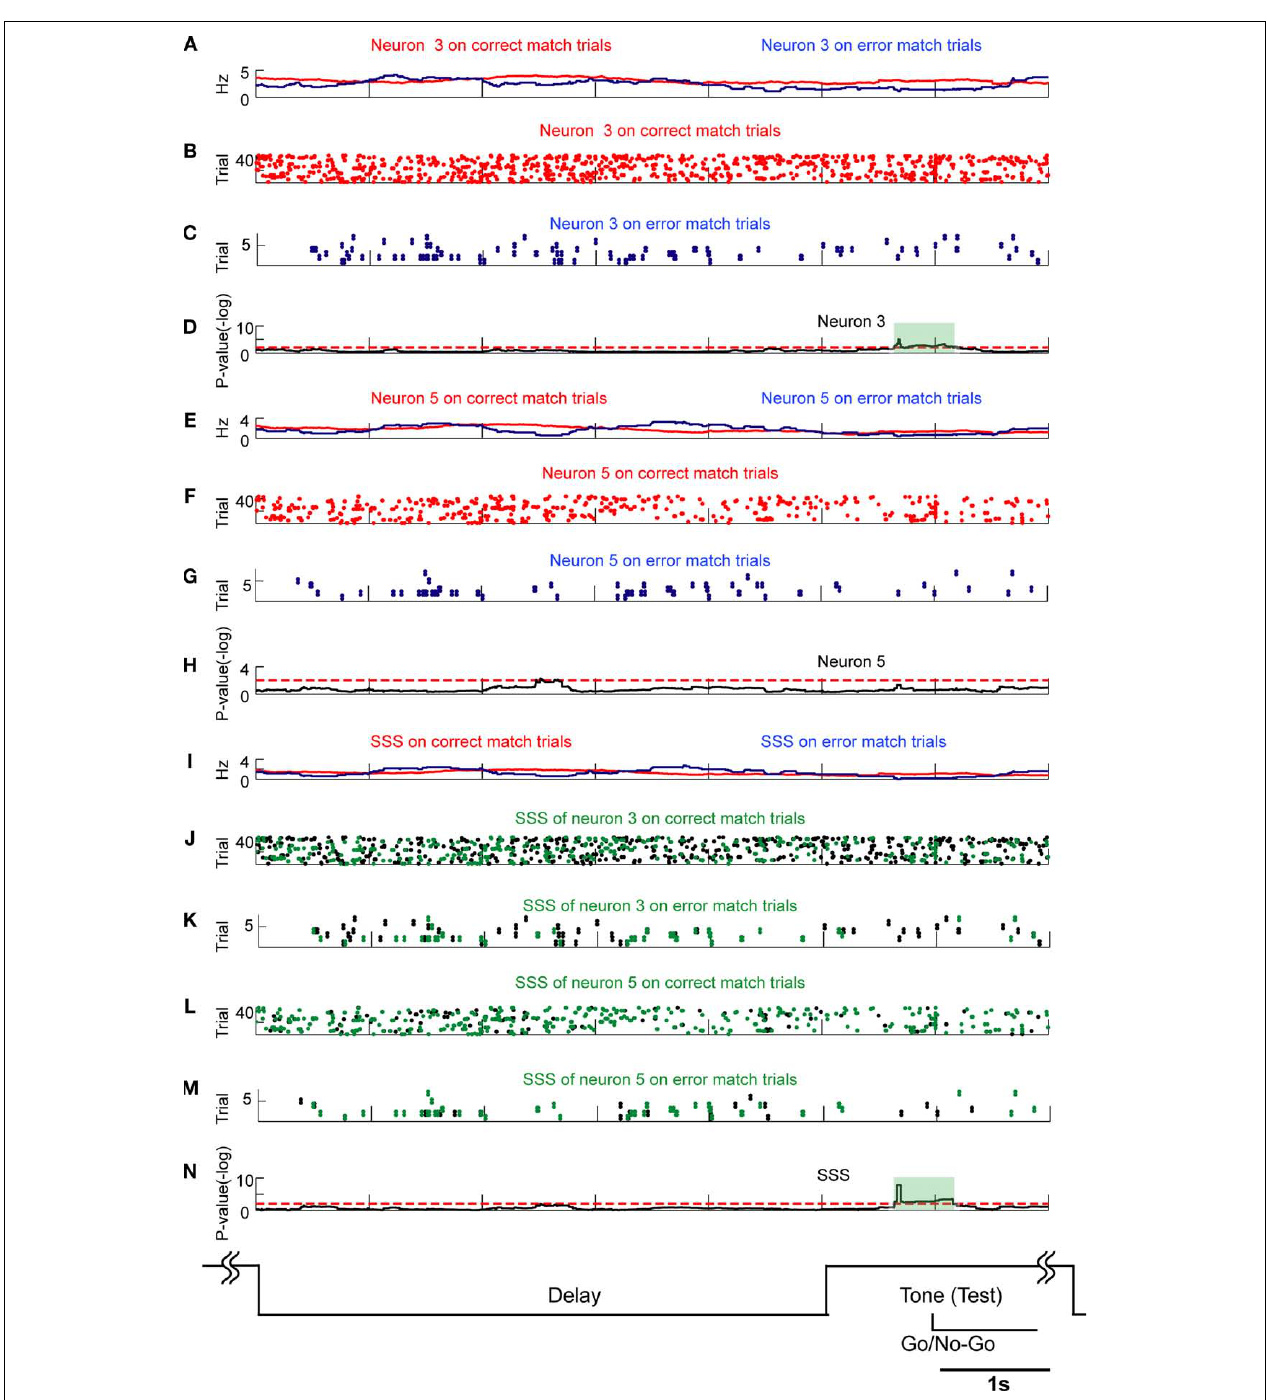
FIGURE 8 | SSSs related to comparison of the stimuli are associated with fi ring rate modulations. Comparison of SSSs and rate modulations between correct match and error match trials was selected in this example. Results of U -tests of 5 s of delay and 2 s of tone presentation are shown. (A) Firing rates of neuron 3 in correct match (red) and error match (blue) trials. (B,C) Raster plots of spikes of neuron 3 in correct match (red) and error match (blue) trials. (D) P -values of neuron 3 for a difference between rates on correct match trials